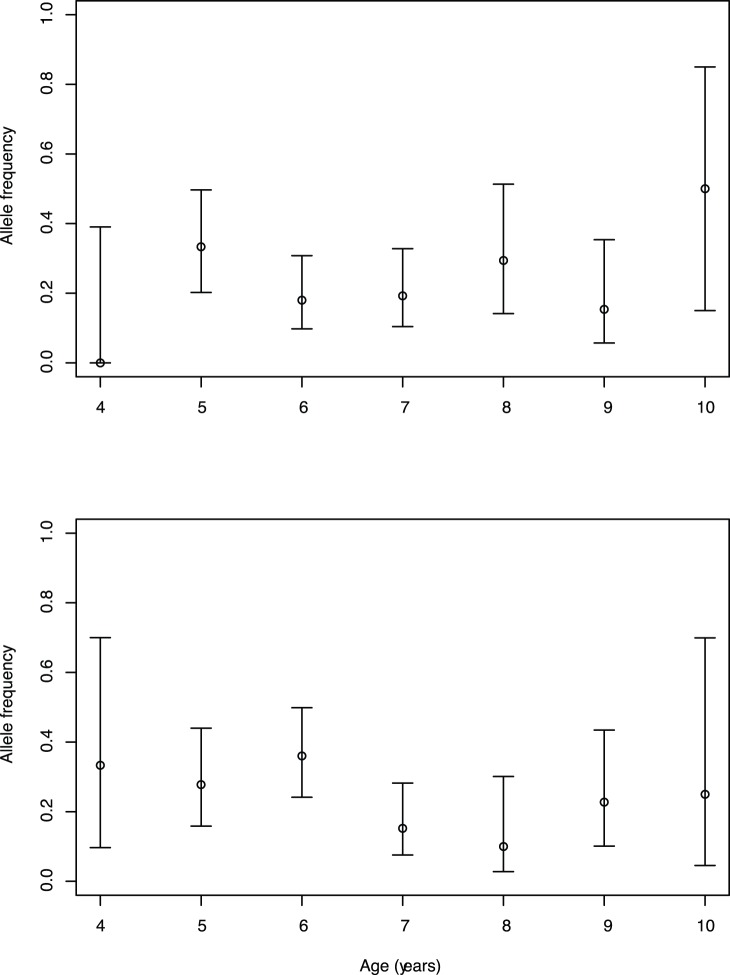
Frequency of MHCIIα.variations in PL-charr from 2005 and 2010 by age classes.The frequency of MHCIIα hap14 (with 95% confidence intervals) by age of PL charr, collected in years 2005 (A) and 2010 (B) at the spawning grounds in Lake Thingvallavatn.